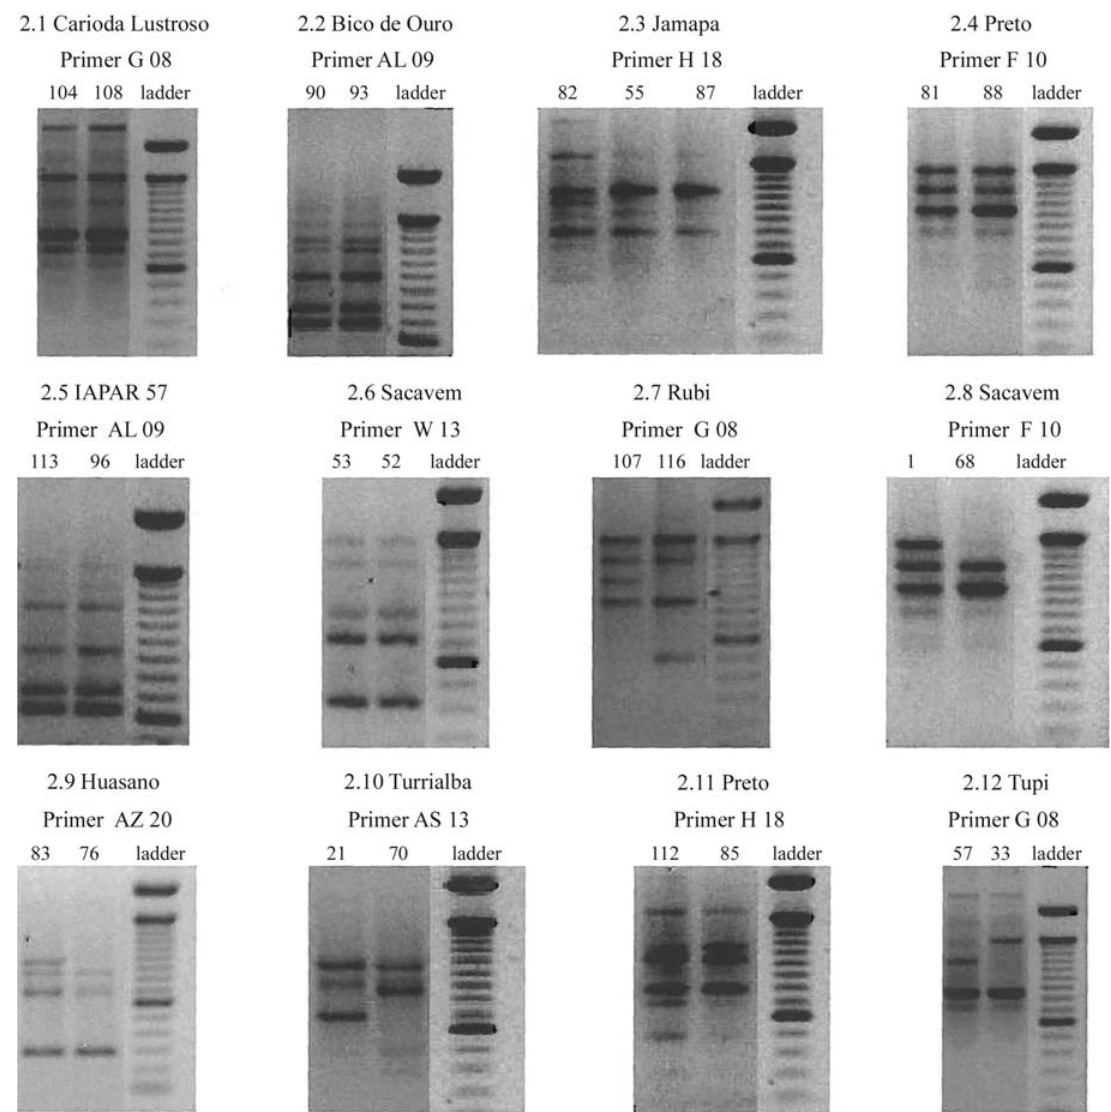
Figure 2 - Random amplified polymorphic DNA (RAPD) molecular marker agarose gel for the genetic differentiation of duplicate accessions in the ac- tive IAC Common Bean Germplasm Bank. The accession numbers correspond to those presented in Figure